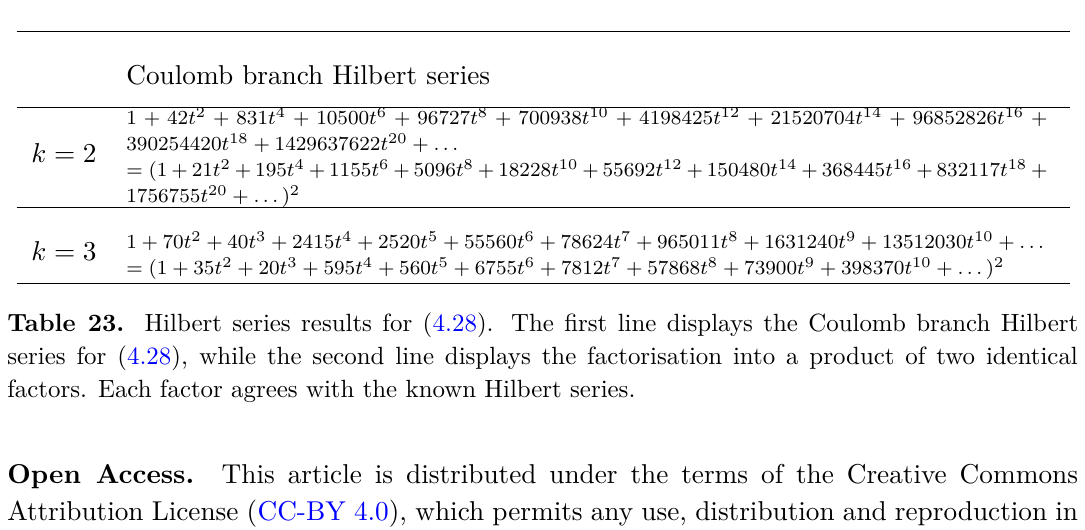
Table 22. Hilbert series results for (4.25). The first line displays the Coulomb branch Hilbert series for (4.25), while the second line displays the factorisation into a product of two identical factors. Each factor agrees with the known Hilbert series.